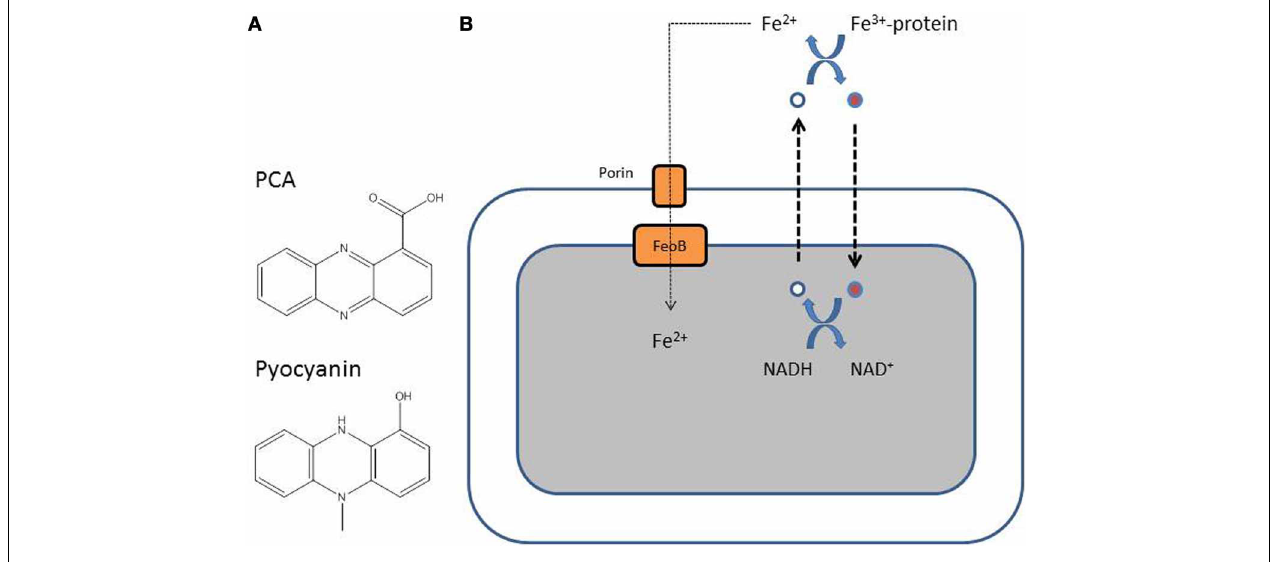
FIGURE 4 | (A) Structure of the two major P. aeruginosa phenazines, phenazine-1-carboxylic acid (PCA), and pyocyanin. (B) Reduced PCA (white-filled circle) is excreted out of the cell and is oxidized (red-filled circle)